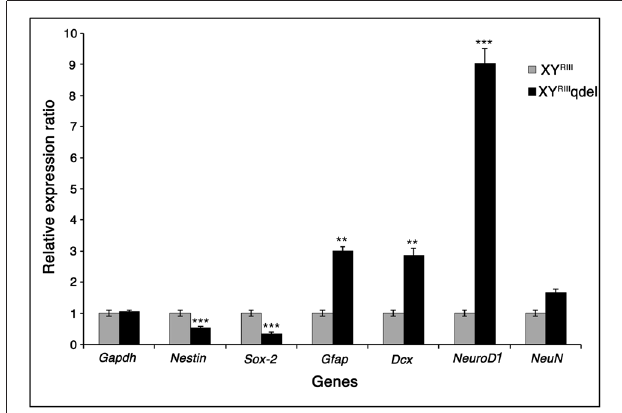
FIGURE 8 | The mRNA expression level of neurogenesis markers. This figure shows the m-RNA expression level of neurogenesis markers in XY RIII and XY RIII qdel mice, with reference to Gapdh . The proliferation markers Nestin and Sox-2 ( P < 0.001, ∗∗∗ ) showed significant reduction in expression while the differentiation markers were upregulated in XY RIII qdel compared to XY RIII mice. Gfap and Dcx show upregulation at a significance level of P < 0.01, ∗∗ and NeuroD1 , P < 0.001, ∗∗∗ ). Students t -test was used to calculate the statistical